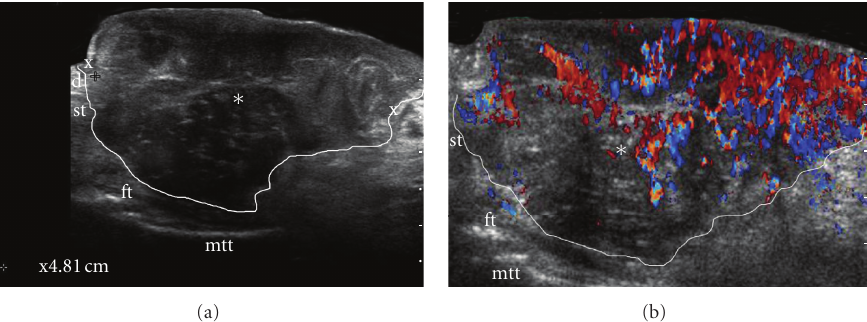
Figure 4: Bulky melanoma at the plantar region. (a) Ultrasound (longitudinal view) shows heterogeneous mass ( ∗ , and outlined) infiltrating dermis and subcutaneous tissue, almost reaching the flexor tendon (fl) close to the second metatarsal bone (mtt). (b) Color Doppler ultrasound shows highly increased blood flow covering most parts of the